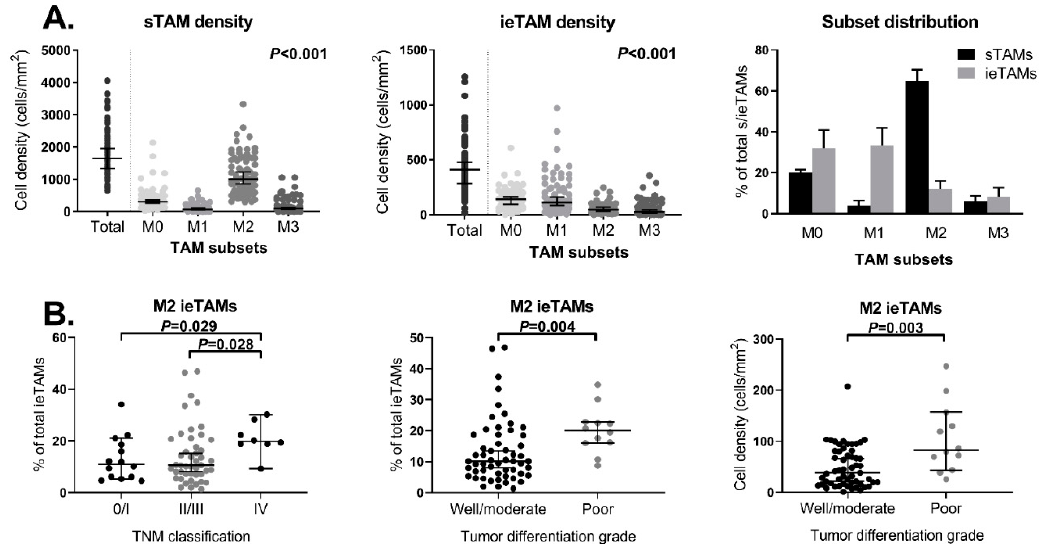
Figure 5. Distribution of the TAM subsets in the stromal and intraepithelial compartments of primary colorectal tumors as measured by multiplex immunofluorescence in relation to clinicopathological parameters. ( A ) Distribution of the sTAM and ieTAM subsets (CD68 + iNOS − CD163 − M0, CD68 + iNOS + CD163 − M1, CD68 + iNOS − CD163 + M2 and CD68 + iNOS + CD163 + M3 TAMs) in primary colorectal tumors ( N = 72 and N = 68, respectively). ( B ) Associations between the percentage of M2 ieTAMs and TNM stage (stage 0/I, N = 14; stage II/III, N = 46; stage IV, N = 8), and between the percentage of M2 ieTAMs and M2 ieTAM density and tumor differentiation grade (well/moderate, N = 55; poor, N = 12) in primary colorectal tumors. The bars show the median with a 95% CI. Statistically significant p -values ( ≤ 0.05) are indicated in bold. Abbreviations: CI (confidence interval), CRC (colorectal cancer), iNOS (inducible nitric oxide synthase), ieTAM (intraepithelial TAM), sTAM (stromal TAM), TAM (tumor-associated macrophage), TNM (Tumor, Node, Metastasis).